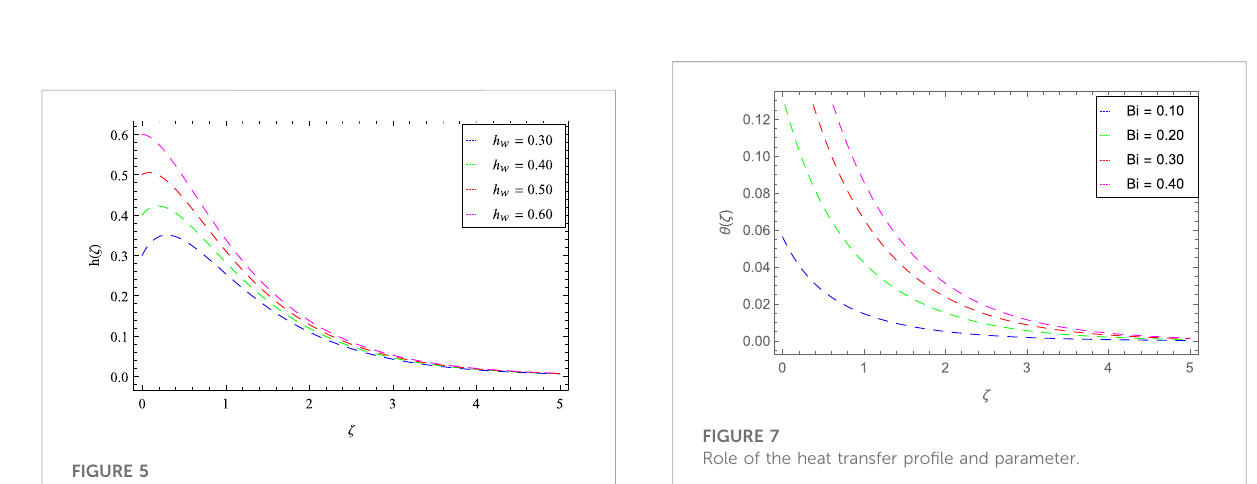
FIGURE 6 Role of the radial velocity pro fi le and parameter.